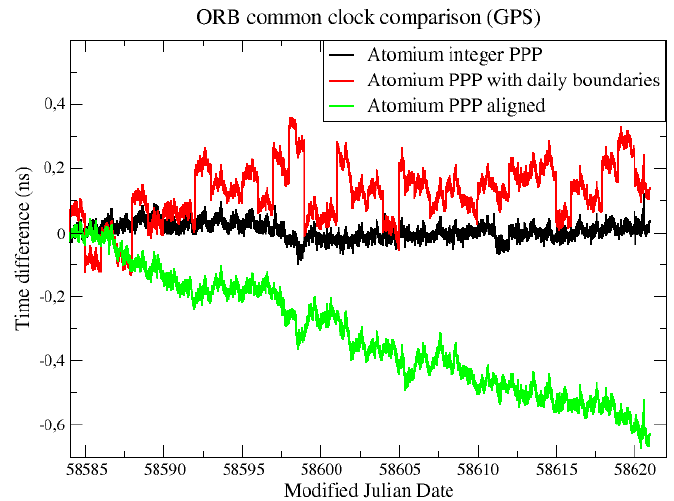
Figure 16. CCD results in ORB using Atomium integer PPP and original Atomium PPP.